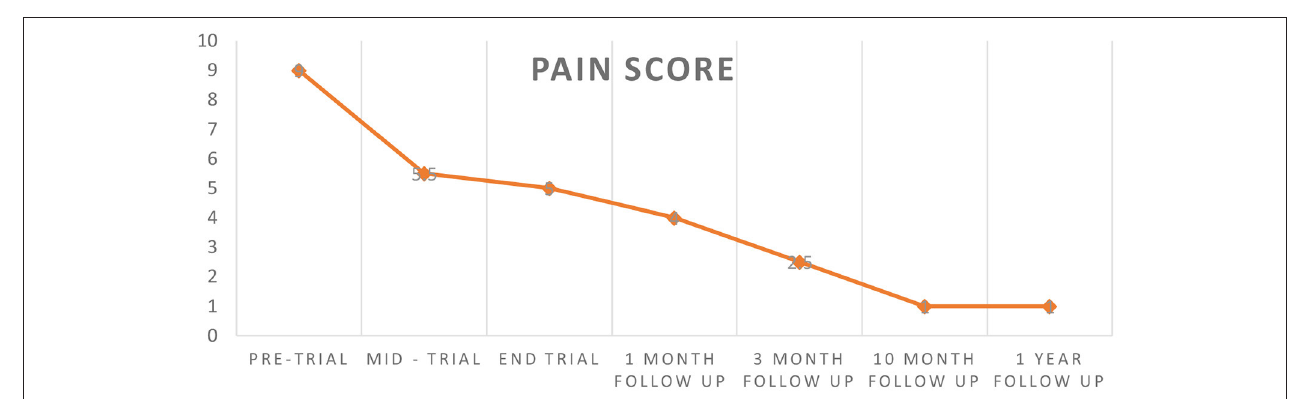
FIGURE 3 | Pain score—pre, mid, end trial and follow up—please refer to text.